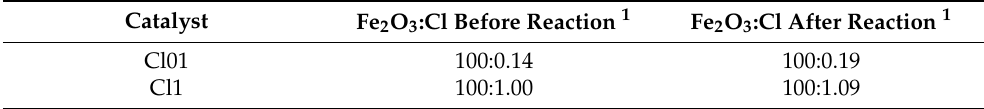
Table 3. Chlorine content of Cl01 and Cl1 before and after Fischer–Tropsch synthesis reaction. Catalyst